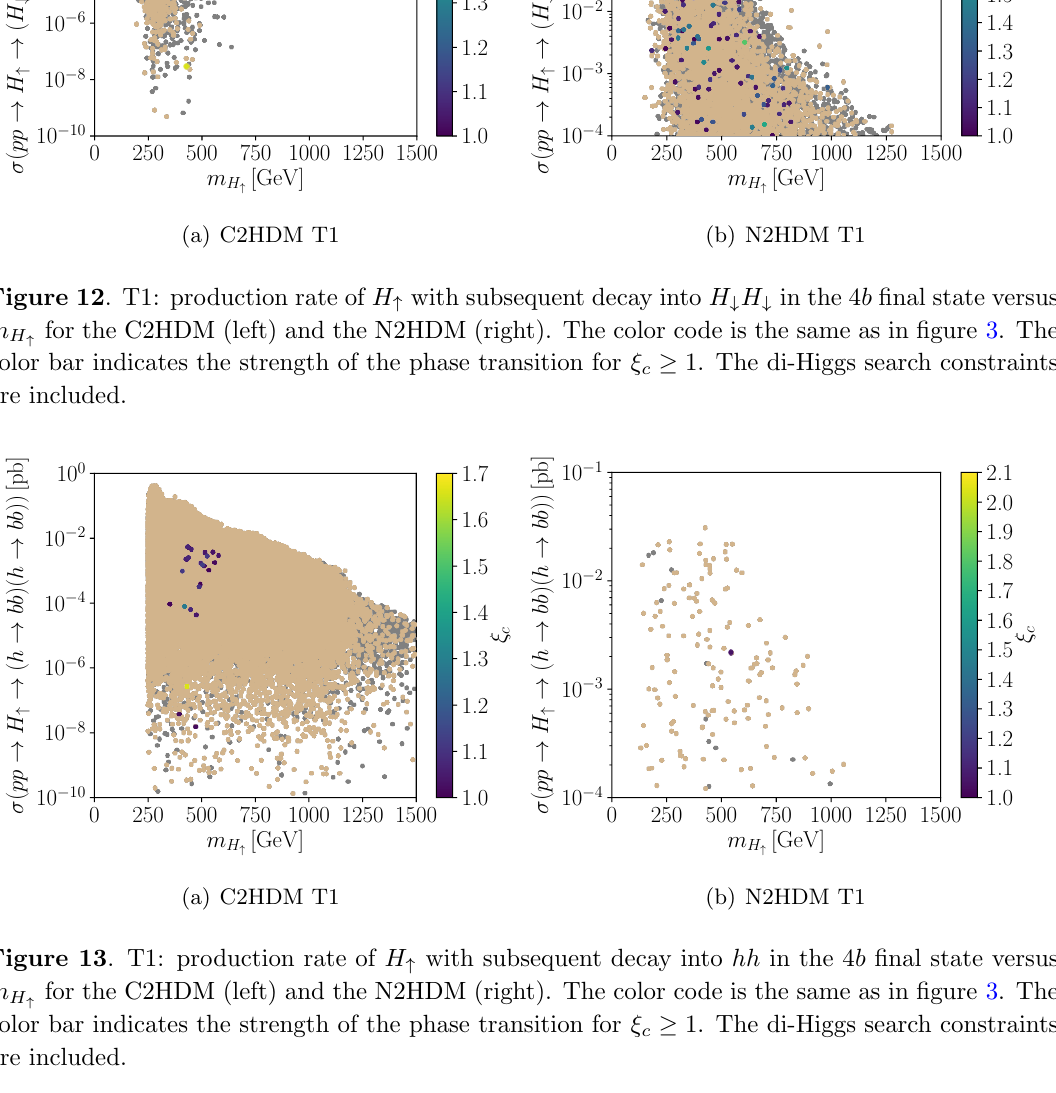
1. The di-Higgs search constraints (cid:21)